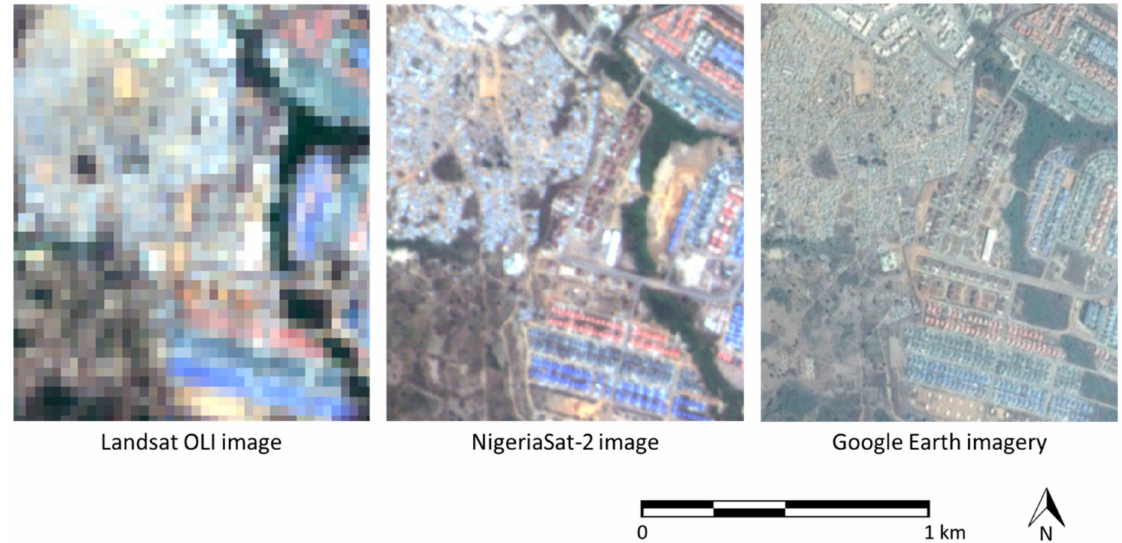
Figure 2. Contrast between planned (east of image) and unplanned (northwest of image) urban development in Kabusa district, as represented by three di ff erent false color composite images captured in January 2014: Landsat operational land imager, NigeriaSat-2 and Google Earth imagery. (Landsat OLI image supplied by US Geological Survey, NigeriaSat-2 image supplied by Nigeria Space Research and Development Agency and Google Earth imagery © 2018 CNES /